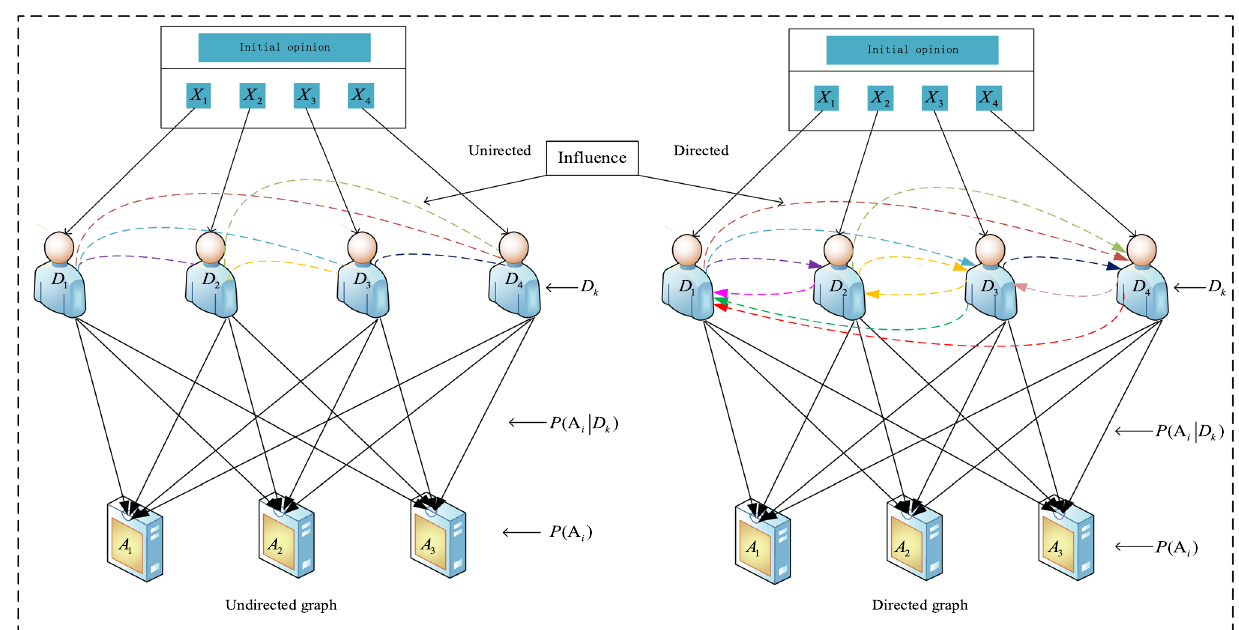
Fig. 3 An example of influence diagram for a SN-GDM